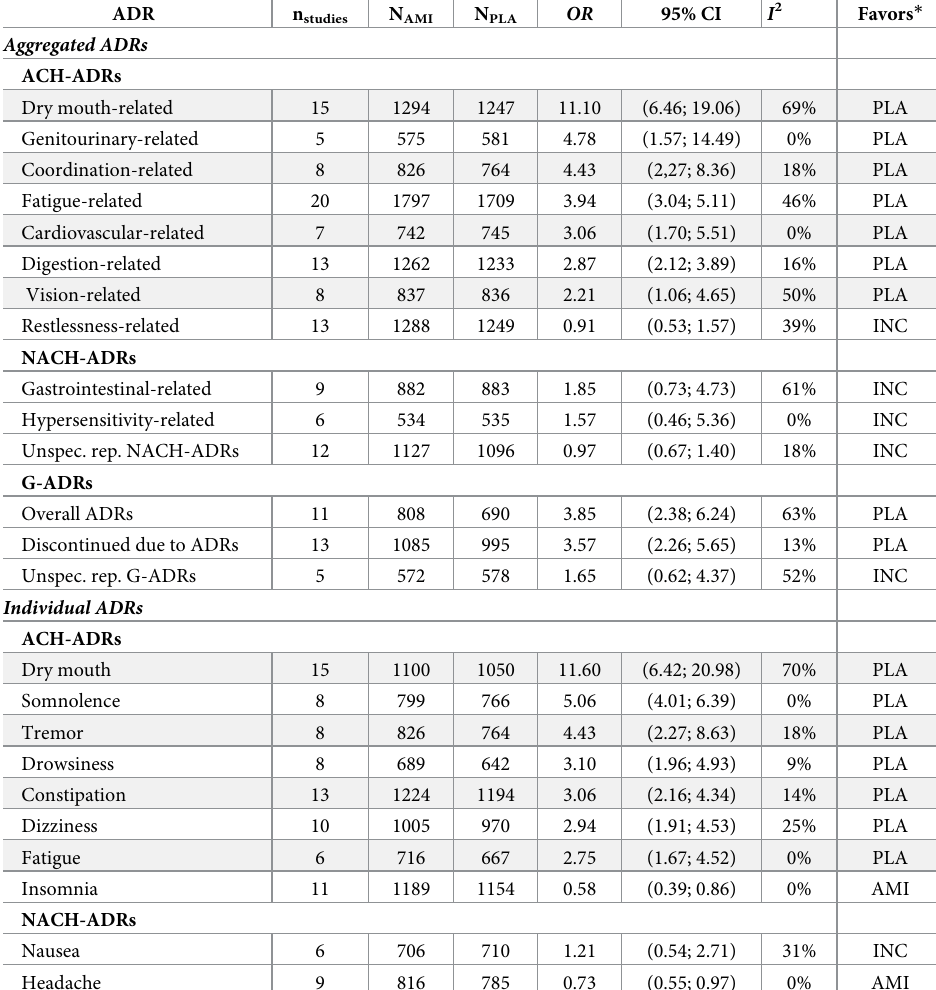
Table 2. Meta-analytical results of secondary